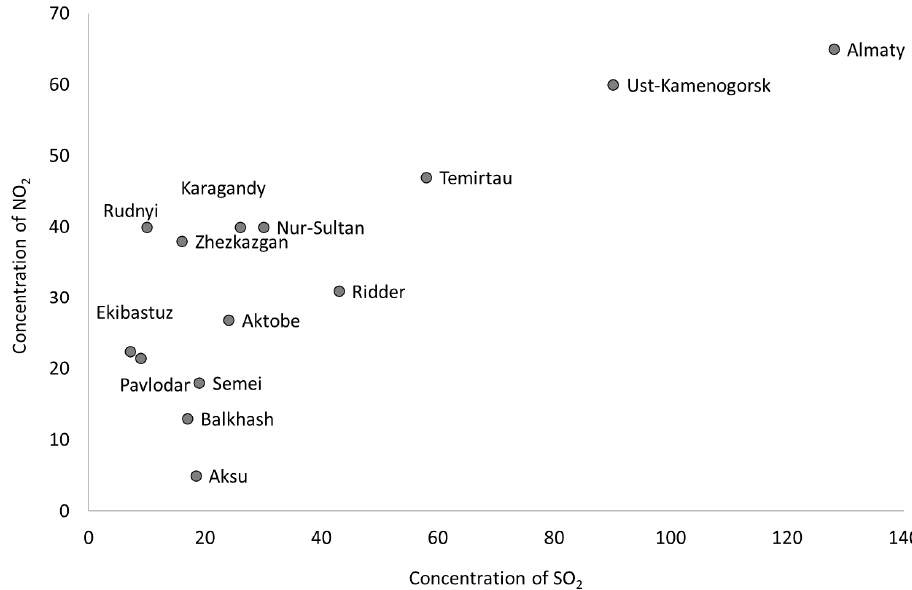
Figure 3. Average annual concentrations of SO 2 and NO 2 in cities in Kazakhstan in 2019, µ g m − 3 . Data source: [33]. Table 4. Monthly average concentration of pollutants by selected cities in 2019, µ g m − 3 .